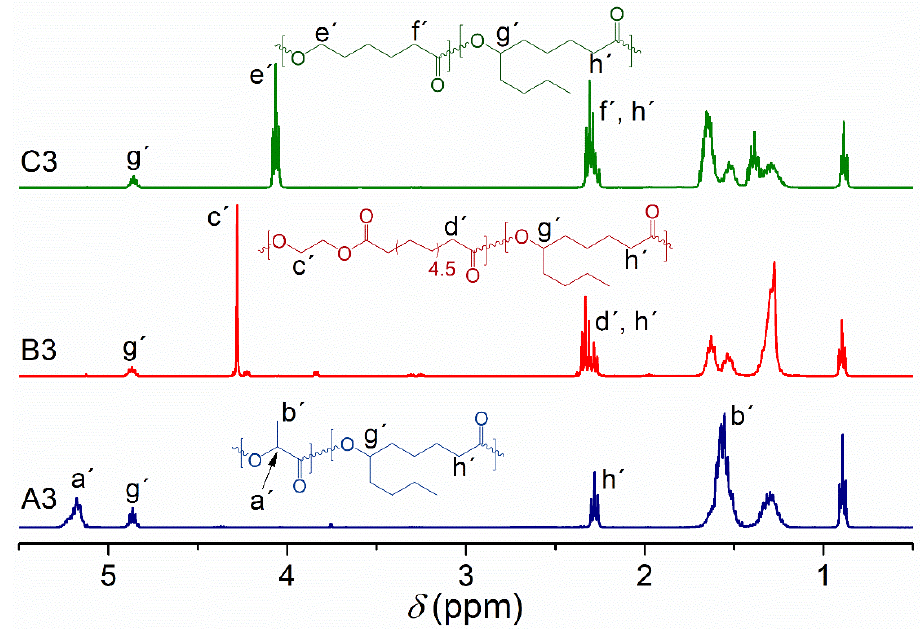
Figure 1. 1 H NMR spectra of representative polyesters A3, B3 and C3.